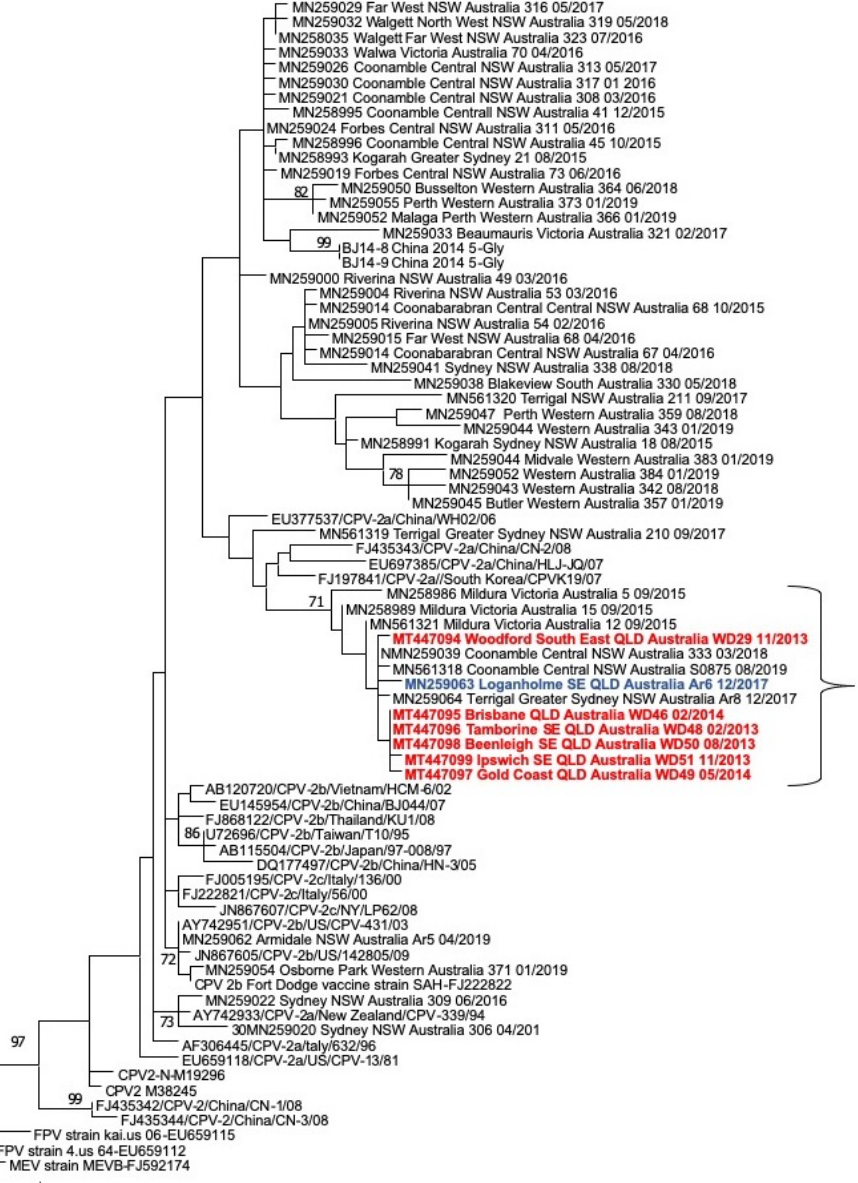
Figure 4. Phylogeny of CPV VP2 sequences from wild dogs in Australia (red) and a domestic dog (blue) within 10 km of the wild-dog sampling. The evolutionary history was inferred by using the Maximum Likelihood method and Tamura three-parameter model with 1000 bootstrap replicates [45]. Bootstrap values > 70% are shown on the branches. The tree with the highest log likelihood (-4045.79) is shown. The tree is drawn to scale, with branch lengths measured in the number of substitutions per site.